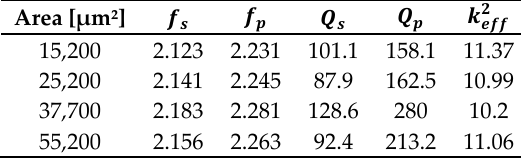
Figure 2. ( a ) Absolute impedance of SMR devices based on ScAlN and on pure AlN. The sample number a x denotes samples with the same geometry at different positions on the die; ( b ) Absolute impedance spectrum of SMR devices with varying surface area A . Table 2. SMR device parameters of ScAlN-based devices with varying resonator